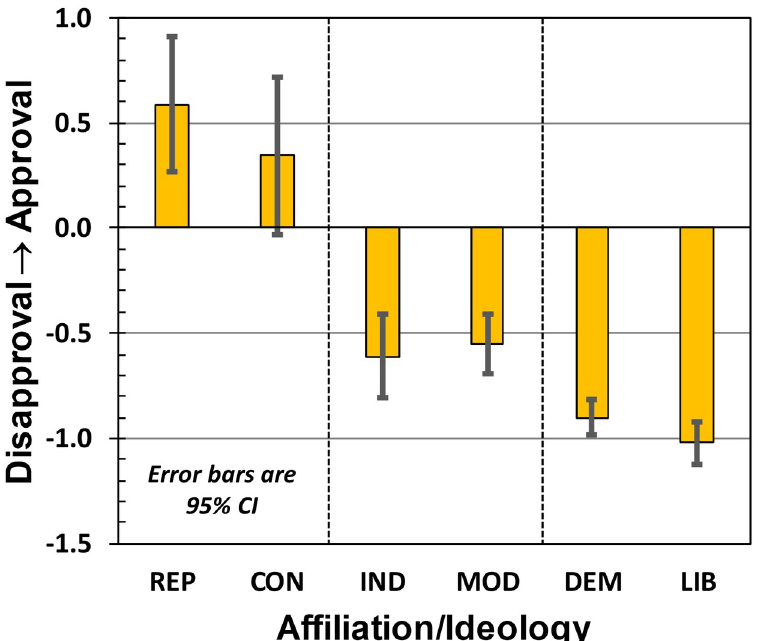
Fig 4. Study-2 results regarding approval of Donald Trump’s presidency.